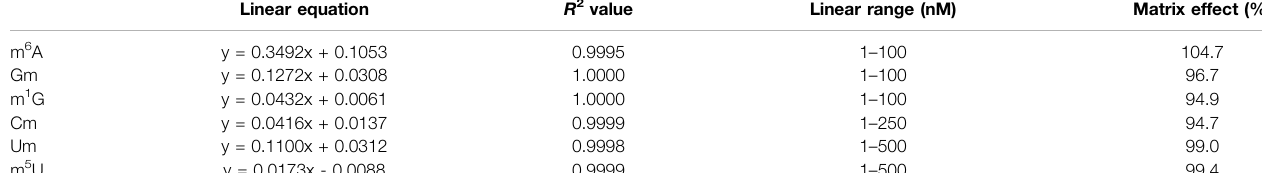
TABLE 1 | Linear equations and matrix effect values of m 6 A, Gm, m 1 G, Cm, Um and m 5 U in HILIC-MS/MS analysis. Linear equation R 2 value